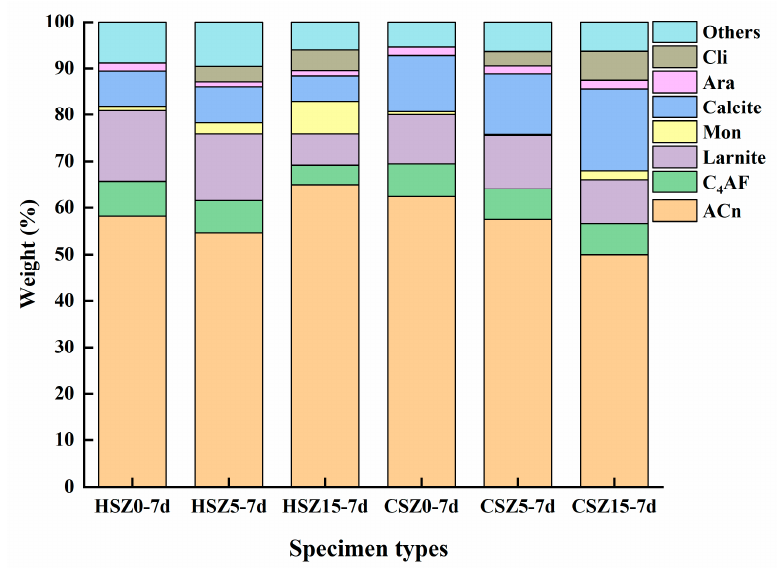
Figure 6. Evolution of minerals SZ specimens during the “H” and “C” process. (H: 7 days hydration; C: 7 days hydration and then 2 h carbonation).